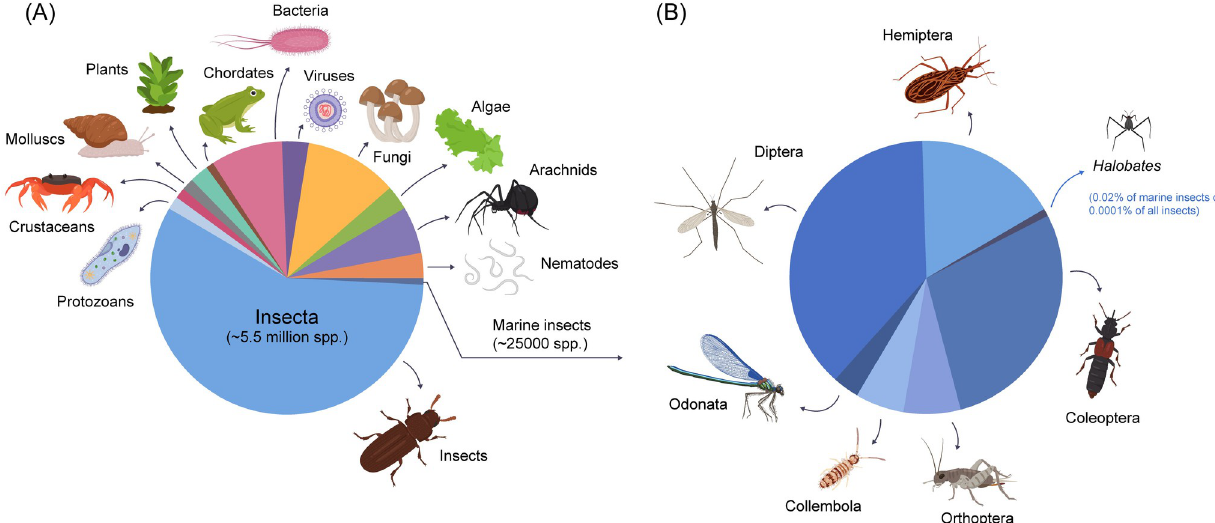
Fig 1. Pie charts showing proportions. (A) Estimated proportions of living organisms on Earth of which > 70% are insects (approximately 5.5 million species), but only a tiny fraction ( < 0.05%) are considered marine, occurring in habitats ranging from brackish salt marshes, mangroves, and intertidal reef flats out to the open ocean. (B) Proportion of 6 major marine insect orders, of which approximately 20% are Hemiptera to which Halobates (approximately 50 species known; only 5 are oceanic) belongs. This illustration was created by Ella Maru Studio